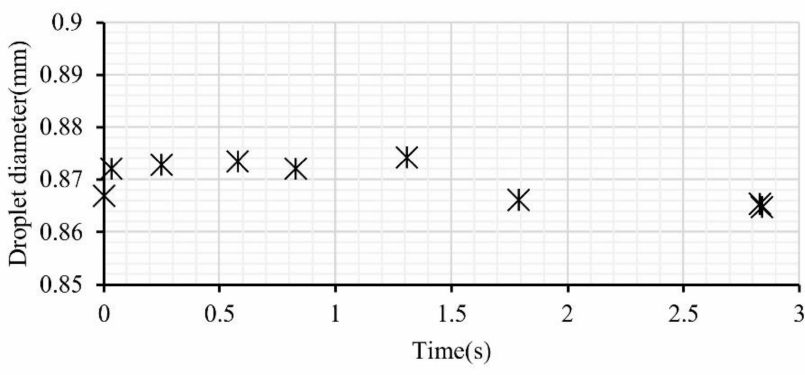
Figure 9. Droplet diameter versus time for sample